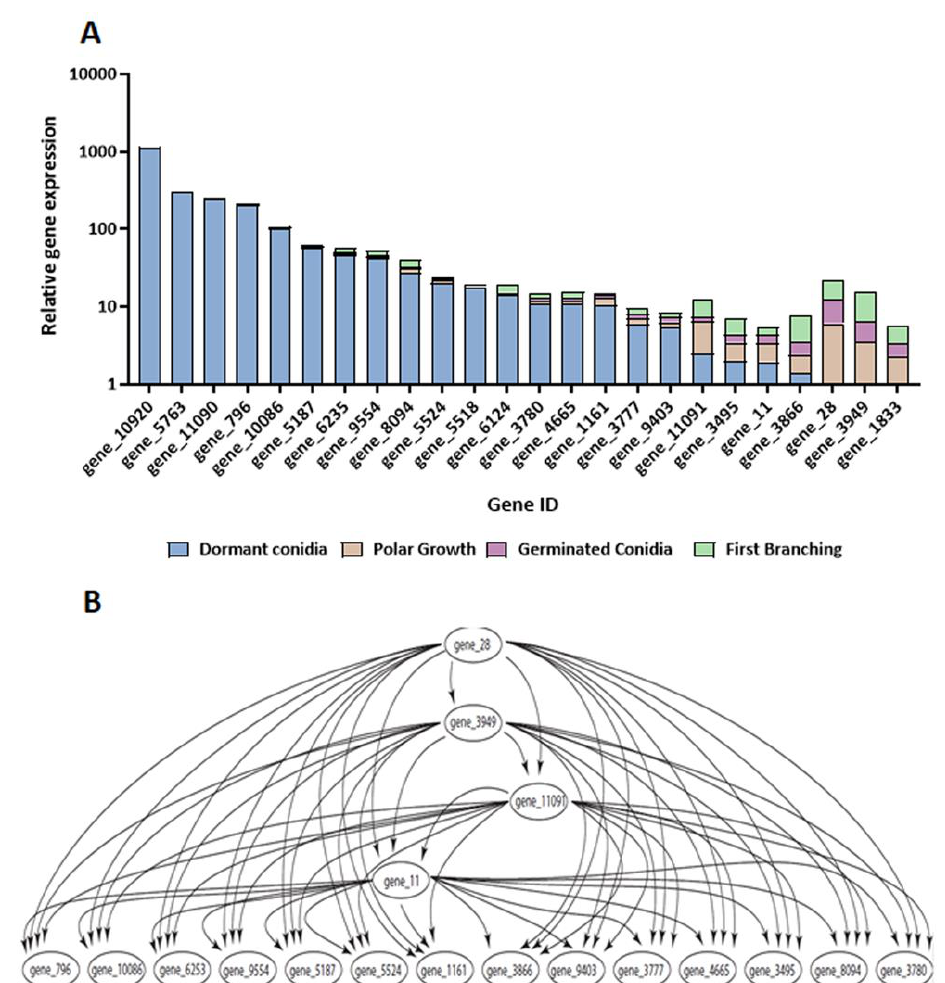
Figure 5. ( A ) Log-scaled relative expression levels of glucanases across conidial germination of Trichoderma asperelloides . Only glucanases with a minimal r value of 1 are presented. ( B ) Bayesian gene expression network, inferred from relative expression among select glucanase-encoding genes.